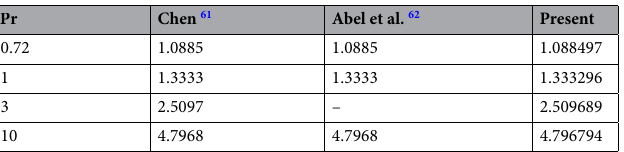
Table 4. Comparison of heat transfer rates for varied estimates of Prandtl number ( Pr ) with Chen 61 and Abel et al. 62 by suppressing the extra